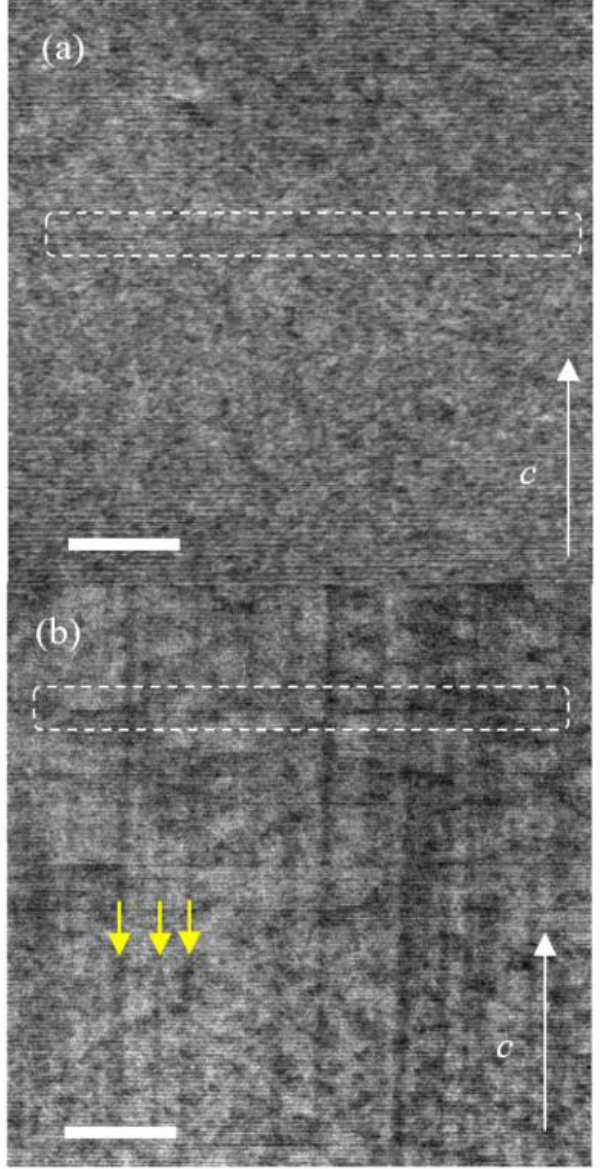
Figure 1. STEM images of ( a ) the pristine and ( b ) 2.6-GeV U-irradiated KCa 2 Fe 4 As 4 F 2 for an electron beam injected along the a axis. Scale bars in ( a , b ) correspond to 50 nm. Broken squares in ( a , b ) emphasize the location of horizontal black lines in STEM images, which we interpreted to be thin planar defects. Yellow arrows in ( b ) show examples of columnar defects generated by 2.6-GeV U-irradiation.